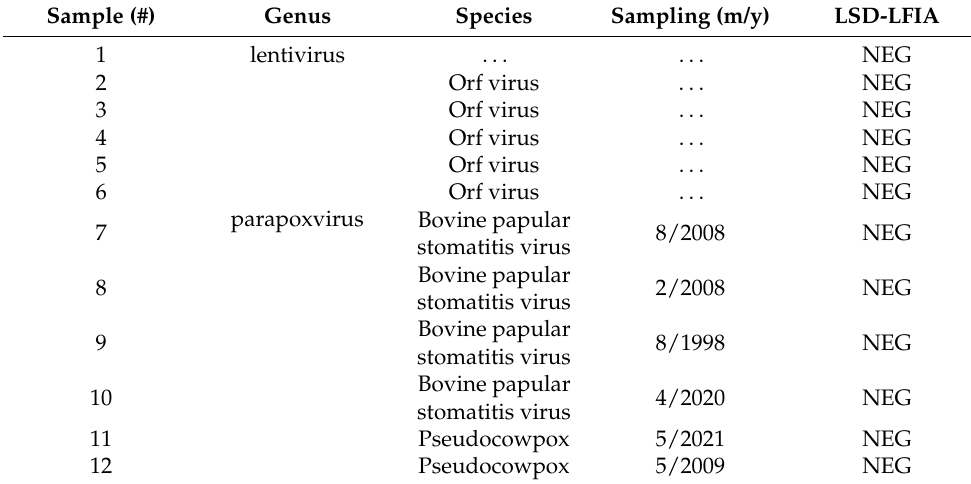
Table 5. List of the viruses tested to evaluate the specificity of